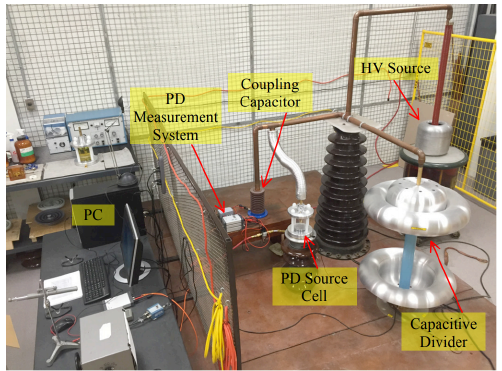
Figure 1. Experimental setup for PD measurement [27].